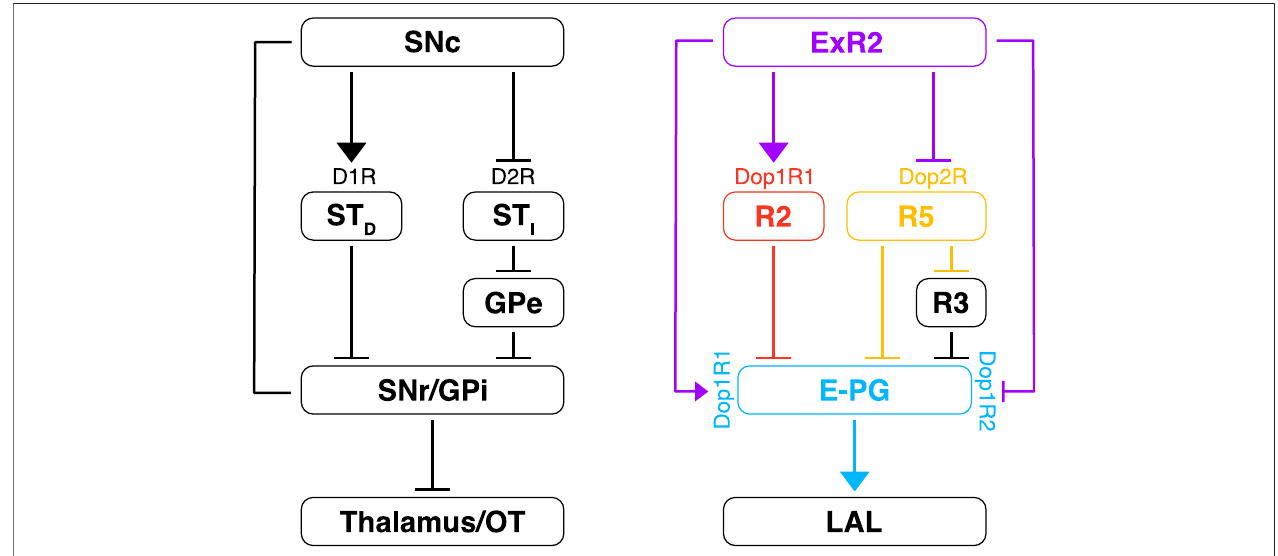
FIGURE9| DopaminemodulationoftheEBandcomparisonwiththevertebratebasalganglia.Ontheleftisdepictedthedopaminecircuitinvolvedinthevertebrate basal ganglia. The dopamine release from the substantia nigra pars compacta (SNc) modulates the direct and the indirect pathway. The striatal neurons (ST D ) of the direct pathway express the D1R (excitatory) and they inhibit the GABAergic neurons of the substantia nigra pars reticulata (SNr) and globus pallidus interna (GPi). In the indirect pathway, the striatal neurons express the D2R (inhibitory) and they inhibit the GABAergic neurons ofthe globus pallidus externa (GPe) which, in turn, inhibit theGPi.Boththesepathways converge backtothethalamus(with efferencecopies)andtomotorcommandregions liketheoptictectum (OT).Ontherightisproposed a simple model about the dopamine modulation of the CX. As for the vertebrate basal ganglia, dopamine might excite ( via Dop1R1) and inhibit ( via Dop2R) speci fi c R- neurons,R2andR5,respectively,whichsynapsedirectlyand/orindirectlytotheE-PGneurons.Acombinationofexcitatory(Dop1R1)andinhibitory(Dop1R2)dopamine receptors would be expressed by the E-PG neurons. The overall computation could serve the selection of goal-directed behaviors that is subsequently passed to the LAL for motor control. T-shaped bars mean inhibitory connections while arrows mean excitatory